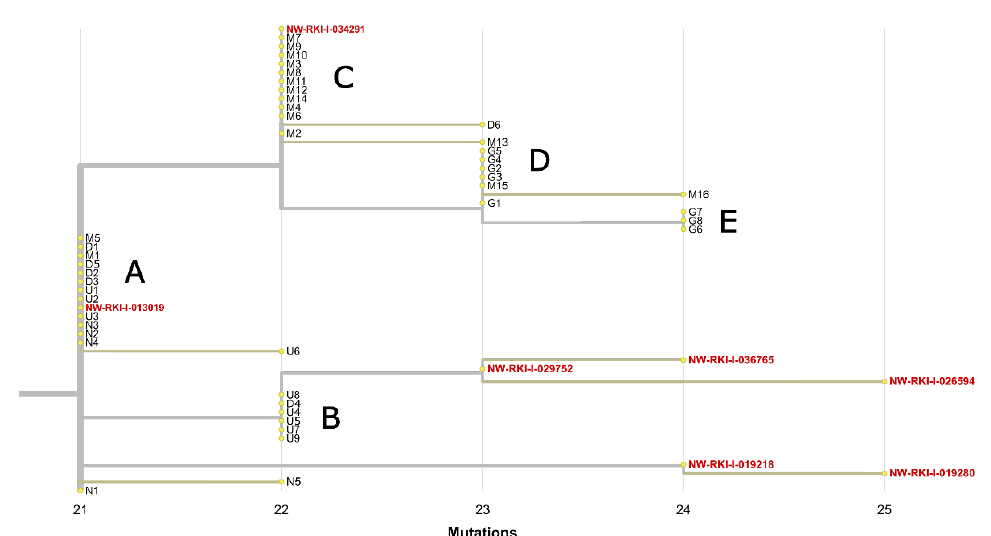
Figure 4. Maximum-likelihood phylogenetic tree from Nextstrain [22,30] comprised of the 44 complete SARS-CoV-2 genomes from the hospital outbreak samples and seven SARS-CoV-2 sequences most probably resulting from a local spread of the hospital outbreak to the public. Five infection clusters (A, B, C, D, E) are clearly delineated from each other and outbreak leakage (red) obviously occurred from Clusters A, B and C.